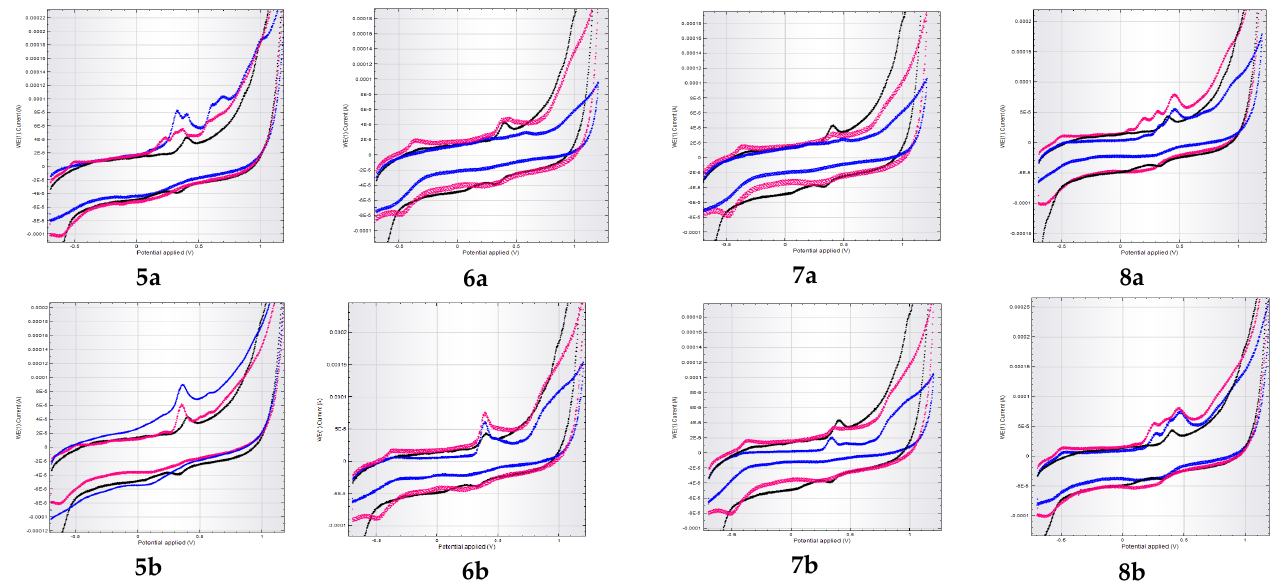
Figure A5. Overlapped CVs for 0.5 mM DPPH ˙ (black); 0.5 mM solution of the synthesized compounds (blue) and of solutions with equal concentrations of 0.5 M of DPPH ˙ and one compound at a time (pink) prepared in 0.1 M HClO 4 on graphite SPE.